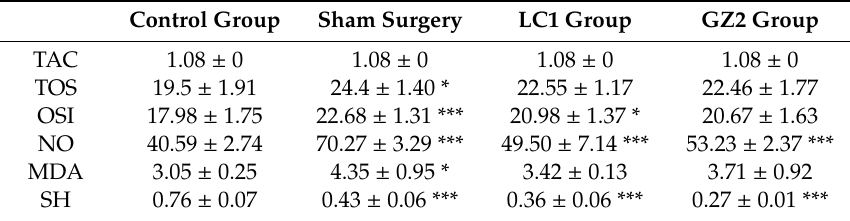
Table 3. Changes in the systemic oxidative stress status in response to the surgical bone defect and graphene material treatment.